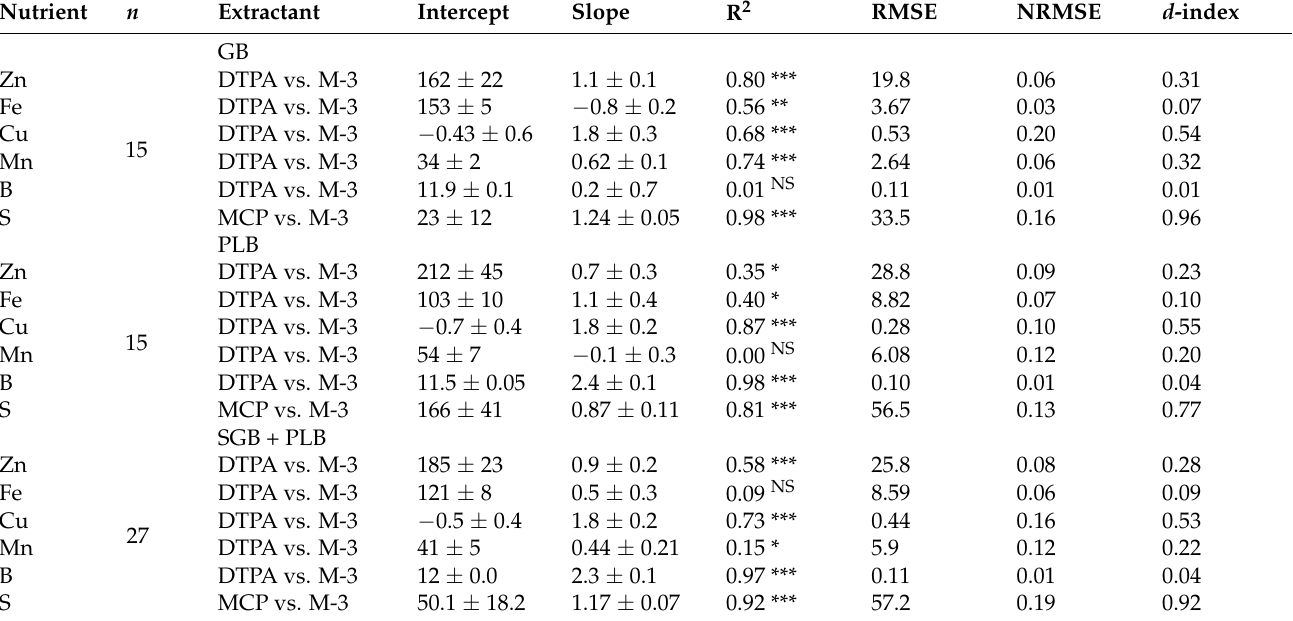
Table 4. Parameters of simple linear regression models between DTPA- and M-3-extractable Zn, Fe, Cu, Mn, and B and between MCP- and M-3-extractable SO 4